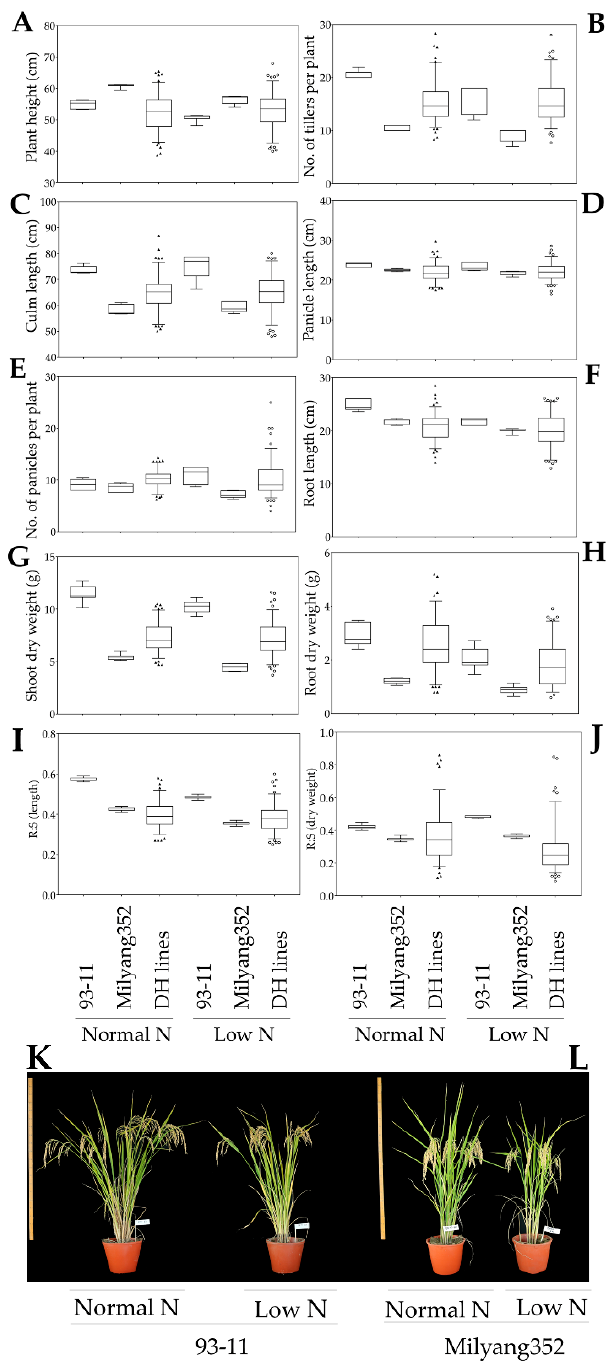
Figure 2. Genotype–phenotype correlation of the doubled haploid population and parental lines under normal and low nitrogen cultivation conditions. ( A ) The box plot displays the effects of a low nitrogen (N) cultivation regime on the growth of 93-11 (P1, indica), Milyang352 (P2, japonica), and that of a doubled haploid (DH) rice population ( n = 117) compared to the normal N application, ( B ) box plot showing the number of tillers per plant, ( C ) culm length, ( D ) panicle length, ( E ) number of panicles per plant, ( F ) root length, ( G ) shoot dry weight, ( H ) root dry weight, ( I ) root–shoot (R:S) ratio calculated from the root length and plant height, and ( J ) based on the root dry weight and shoot dry weight of the same population, and ( K , L ) phenotypes of 93-11 (P1) and Milyang352 (P2) under the same conditions.